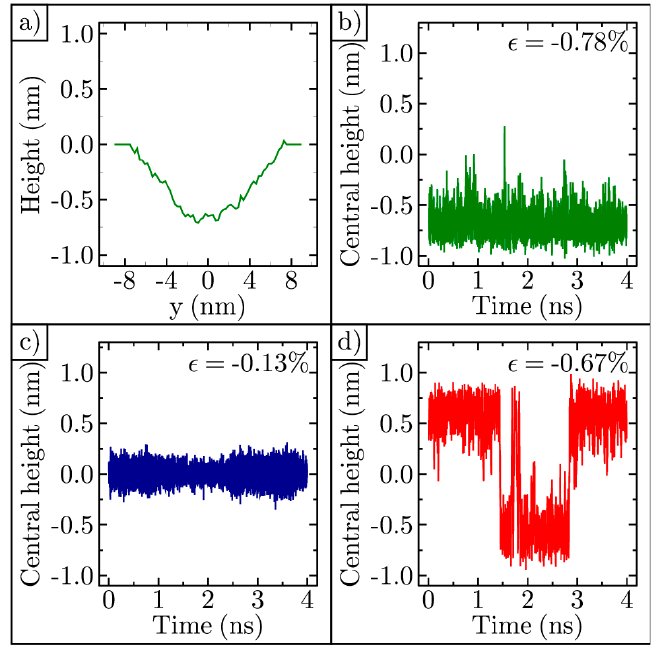
Figure 3. Role of strain on ripple dynamics at 3000 Kelvin: ( a ) Typical cosine-like cross-sectional profile of a ripple; ( b ) Central height of a highly compressed ripple in time; ( c ) Central height of a lightly compressed ripple in time; ( d ) Central height of a bistable ripple in time.